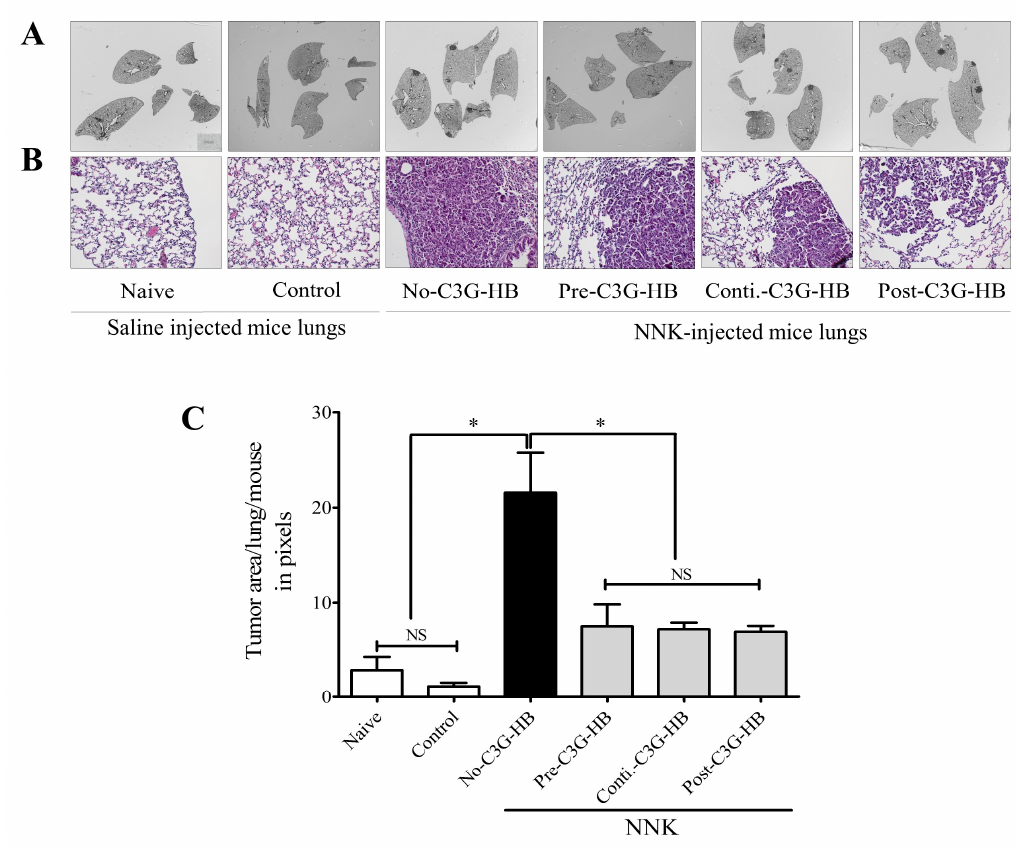
Figure 3. The e ff ect of C3G-HB dietary supplementation on lung tumor area in A / JCr mice. Lung tumors were induced by a single intraperitoneal injection of NNK (100 mg / kg body weight). Saline was injected as a sham for the mice in naive and control groups. Naive mice were fed a regular mouse diet. Mice in control and NNK-injected groups were fed the C3G-HB supplemented diet, except for the mice in no-C3G-HB group (refer to Figure 5). Formalin-fixed lung sections were stained with H and E (3 sections / mouse). ( A ) The whole lung area was imaged, and the tumor area was measured by ImageJ software. ( B ) Representative H and E-stained sections, 200 × magnification. ( C ) One-way ANOVA with Dunnett’s test at α = 0.05 was used for data analysis to compare the treatment e ff ect. No-C3G-HB, not given C3G-HB supplemented diet; Pre-C3G-HB, C3G-HB supplemented diet only before NNK injection; Conti.-C3G-HB, C3G-HB supplemented diet continuously before and after NNK injection; Post-C3G-HB, C3G-HB supplemented diet only after NNK injection. * Indicate statistical di ff erence at p ≤ 0 05 with mean ± SD. NS, Results do not significantly di ff